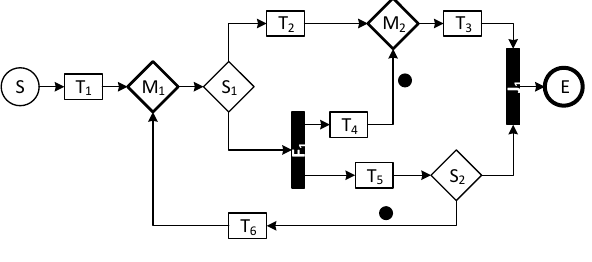
Figure 5. A workflow graph in a state with tokens at edges ( T